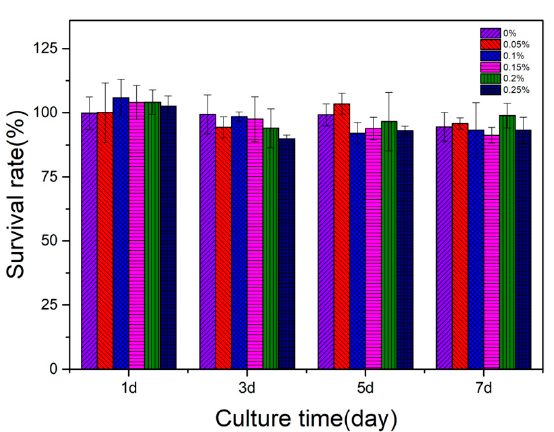
Figure 6. Cytotoxicity assay by culturing L929 fibroblasts in the extracts from PMMA resin containing CNCs-Ag with different mass concentrations, according to ISO 10993-12:200.